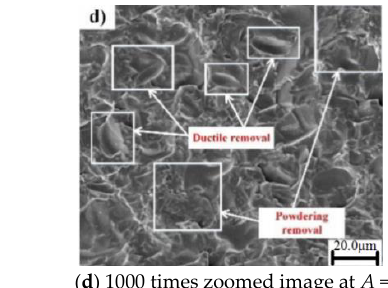
Figure 8. Machined surface morphologies of optical glass material at different ultrasonic vibration status.